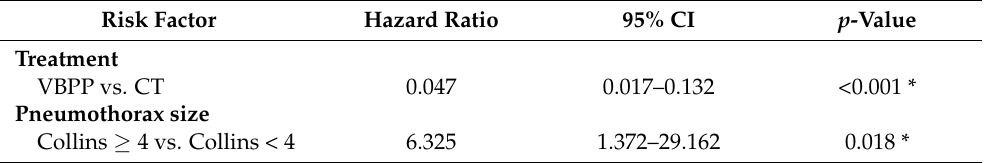
Multivariate analysis displayed initial pneumothorax size and administered treatment as inde- pendent risk factors for PSP recurrence. Chest tube (CT) treatment and a large pneumothorax size (Collins ≥ 4) were associated with a significantly reduced recurren ce-free survival. * p -value < 0.05 indicates statistical significance. VBPP, VATS bullectomy with partial pleurectomy; CI, confiden- tial interval.